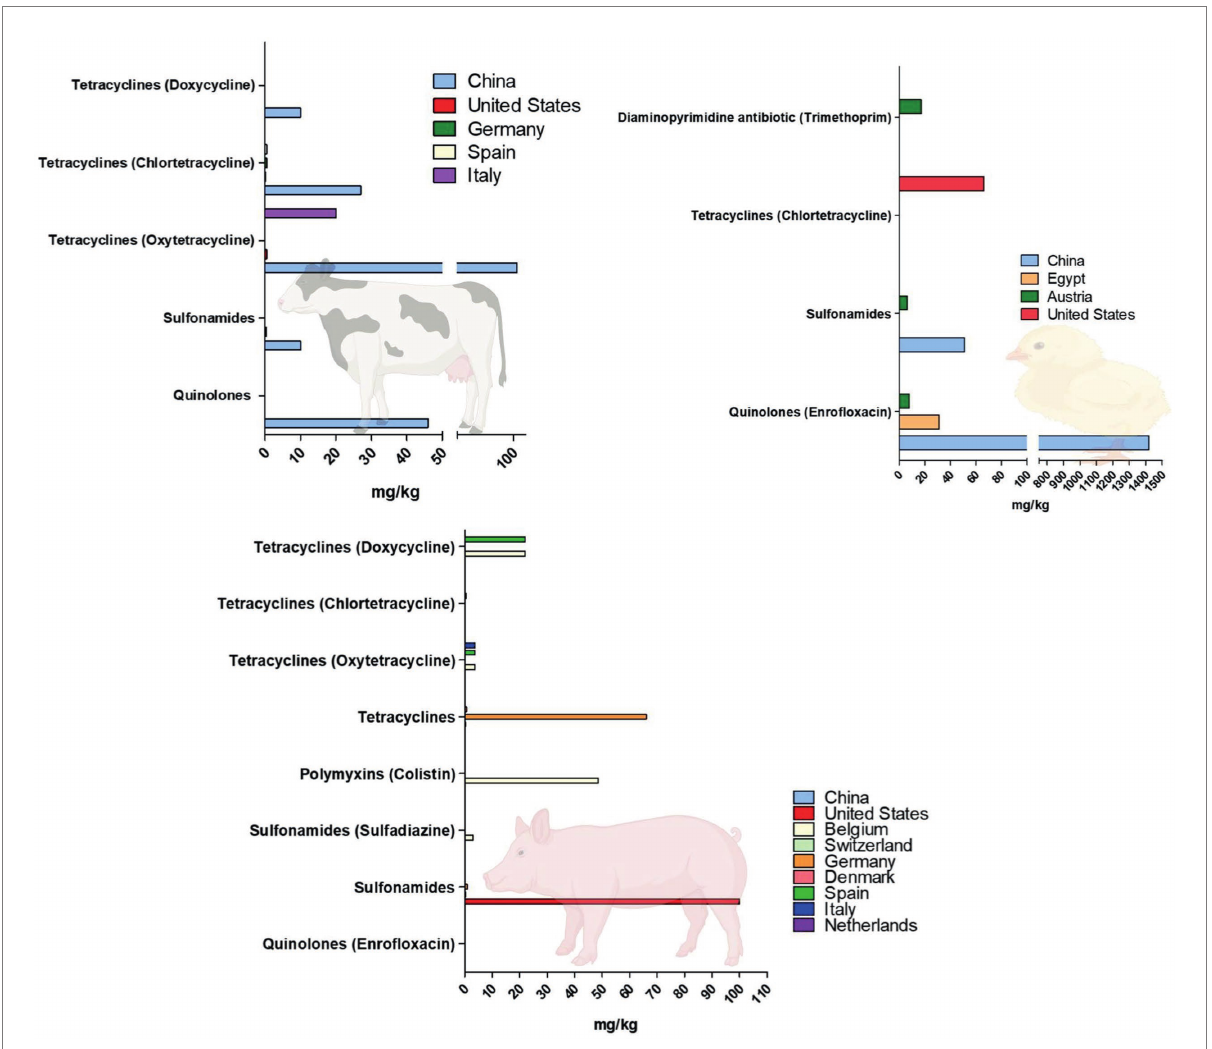
FIGURE 3 Graphic representation of the highest concentrations of antibiotics detected in animal manure (cattle, poultry, swine), reported in different studies. The figure is created using